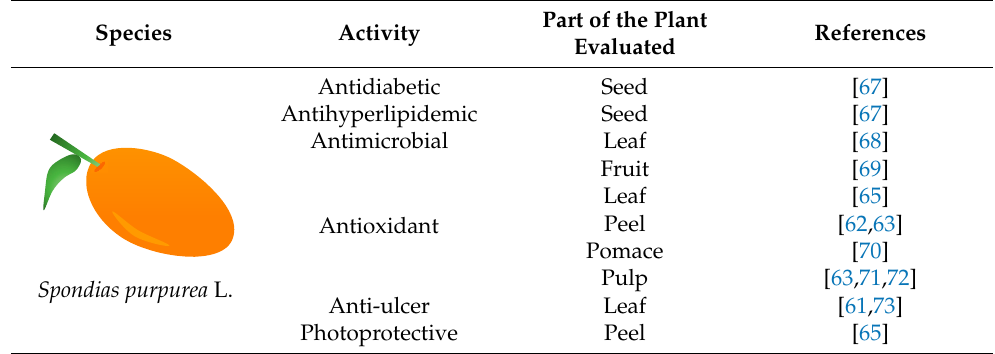
Table 3. Summary of Spondias purpurea L. activity in different parts of the plant, as described in the last few years. Part of the Plant Species Activity